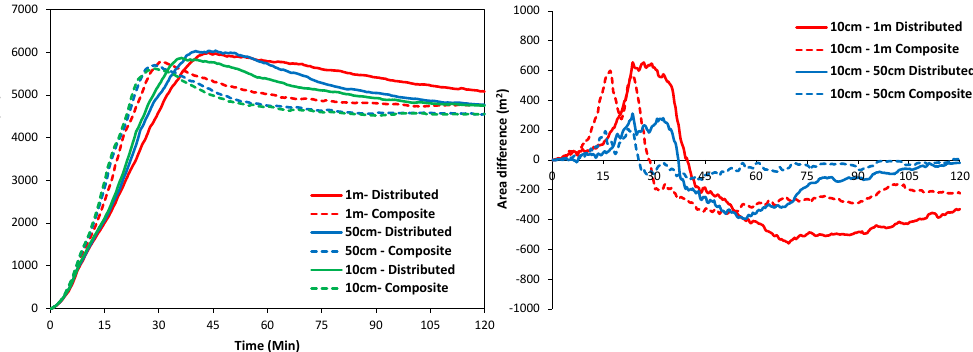
Fig. 7. Predictions of inundated area and differences based on 10cm models through time with different resolutions and roughness conditions.